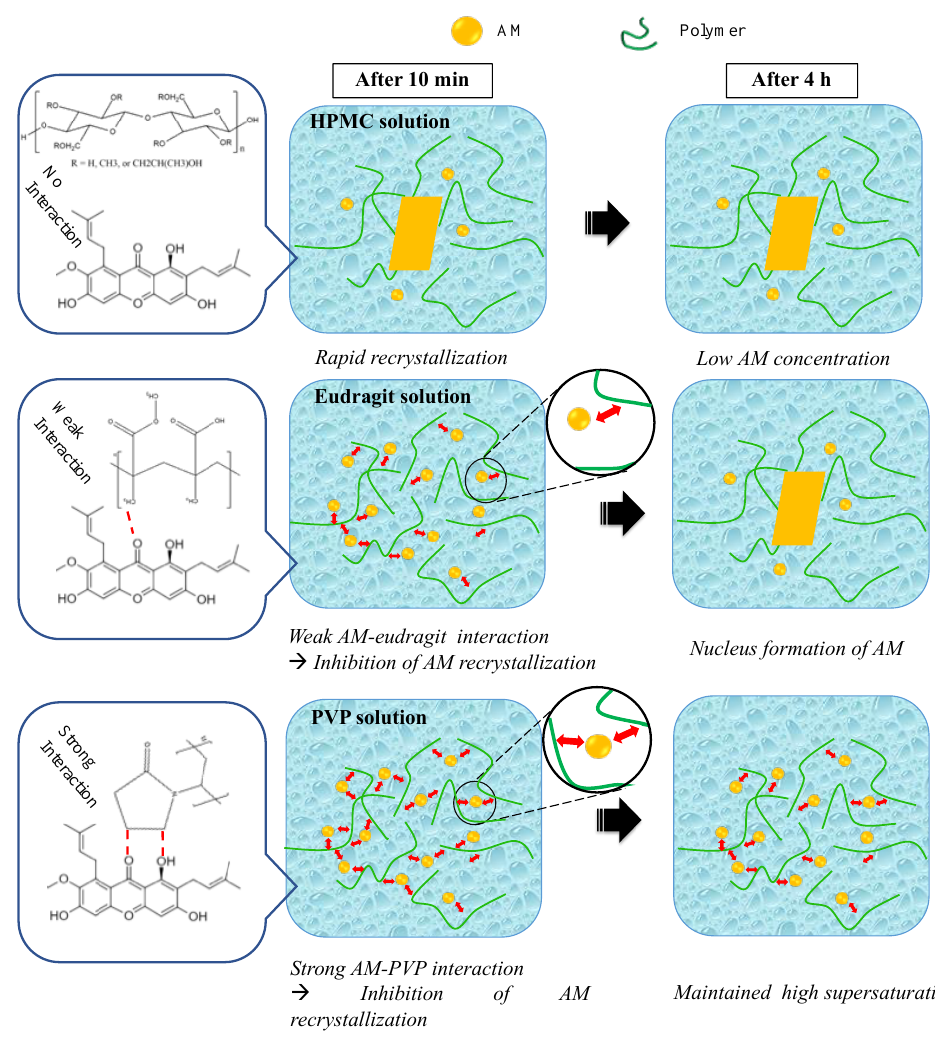
Figure 11. Schematic illustration of crystallization inhibition of AM in each polymer solution.